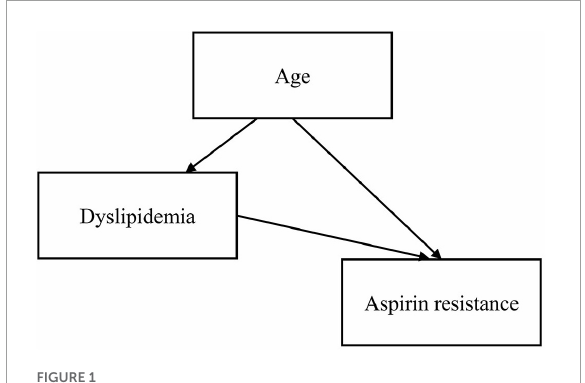
FIGURE1 The directed acyclic graph among age, dyslipidemia, and aspirin